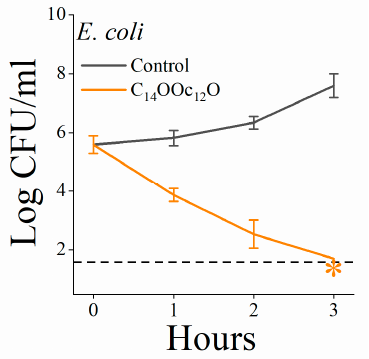
Figure 2. Time-kill kinetics. The bactericidal activity of 10 µ M C 14 OOc 12 O (orange trace) is demonstrated in comparison to the untreated control (black trace) in LB. The dashed horizontal line represents the limit of detection (log 10 50 CFU/mL = 1.69). Orange asterisk (*) denotes lack of detectable CFU.